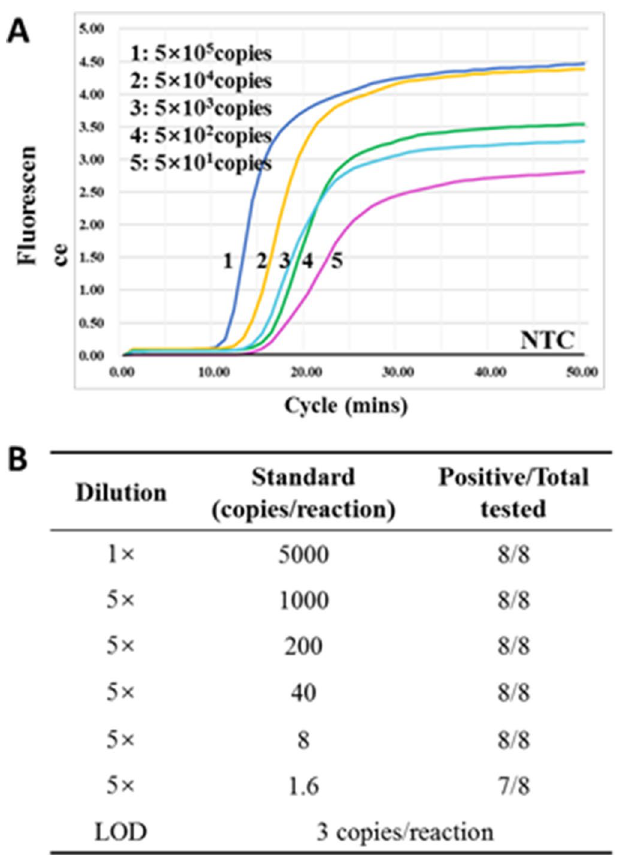
Figure 4. Sensitivity ( A ) and LOD ( B ) of the primer Set-4. NTC non-template